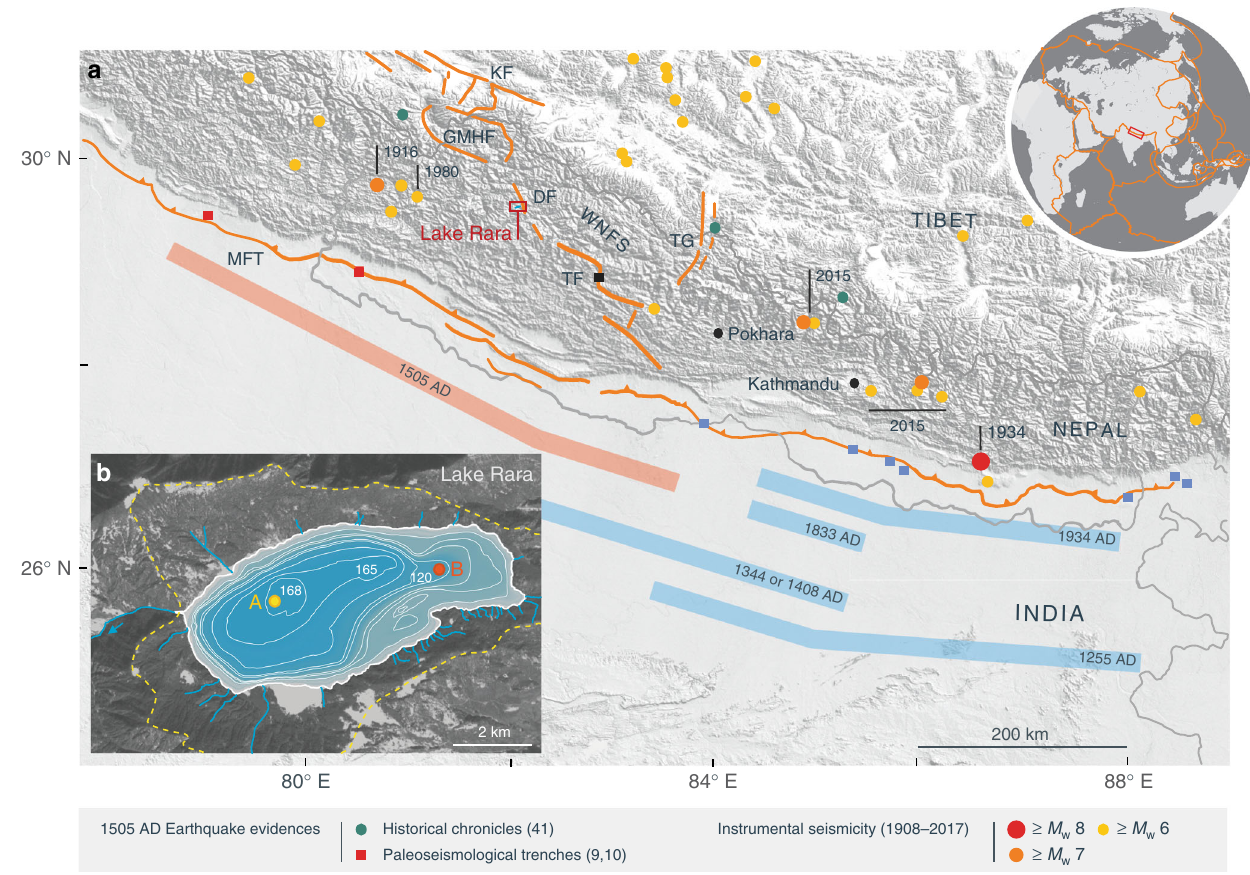
Fig. 1 Geomorphic and seismotectonic setting of Lake Rara. a ASTER Global Digital Elevation model (GDEM) of the central Himalaya, showing active faults 37,57 , instrumental seismicity ( M w ≥ 6) from 1908 – 2017 (2017 update of ISC-GEM 34 ), and inferred rupture lengths of historical earthquakes (dates as indicated). Squares indicate paleoseismological trenching sites, in red for the great 1505 AD earthquake, in black for the Tibrikot earthquake and in blue for central Nepal earthquakes (see main text for references). Green dots are locations for which historical chronicles record destruction during the 1505 AD earthquake 58 . Instrumental seismicity is coloured according to magnitude, earthquakes discussed in the text are indicated by date. Active faults are: KF — Karakoram Fault; MFT — Main Frontal Thrust; TG — Thakkola Graben; WNFS — Western Nepal Fault System (composed in part by: DF — Dharma Fault; GMHF — Gurla Mandhata-Humla Fault system; TF — Tibrikot Fault). The red rectangle shows the location of Lake Rara (inset b ). b Bathymetric map of Lake Rara (from ref. 40 and our own measurements) showing the sampling sites A and B, overlain on a satellite image of the lake catchment (outlined by yellow dashed line, the full catchment is shown in Supplementary Fig. 1; Landsat-7 image courtesy of the U.S. Geological Survey). ASTER GDEM is a product of NASA and